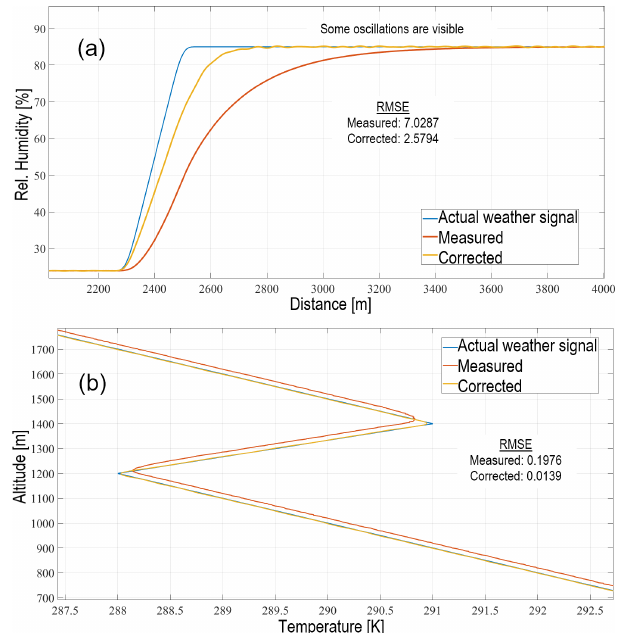
Figure 11. Comparison of weather signals in simulated (a) frontal inversion conditions with relative wind speed of 45ms − 1 and (b) thermal inversion conditions with climbing rate set to 5ms − 1 . Results from before and after applying the IDMP are